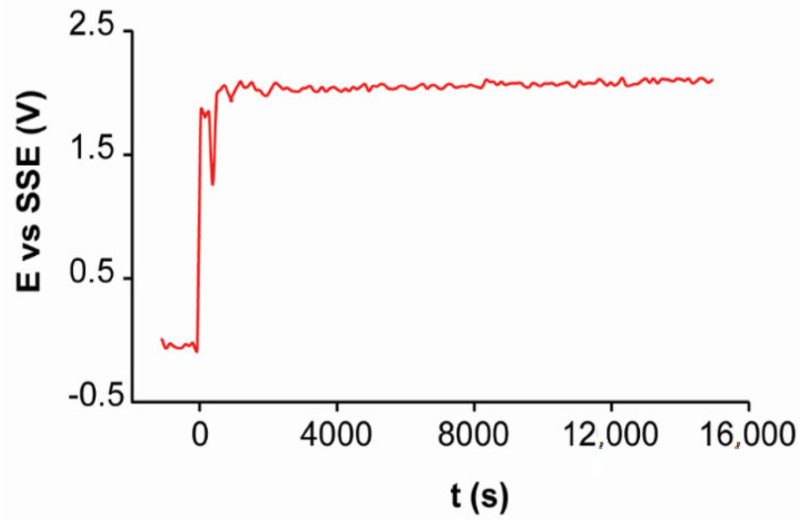
Figure 16. Electrolysis of EBHSS using a current intensity of 100 mA at pH = 2 and T = 25 ◦ C. The comparison of the chronopotentiometric and chronoamperometric analyses of EBHSS (Table 3) indicates that, when a current of 100 mA is applied, the working electrode produces on average a potential of 2 V vs. SSE. Conversely, a potential of 1 V vs. SSE produces a current of 64 mA, showing a significant ohmic drop in the working electrode. According to the results of the microelectrolysis, the slow kinetic electrodissolution of EBHSS may be associated with its low electrical conductivity [37] and the type of electrical contact that prevails in the working electrode, but specifically with the sphalerite particles (contact type